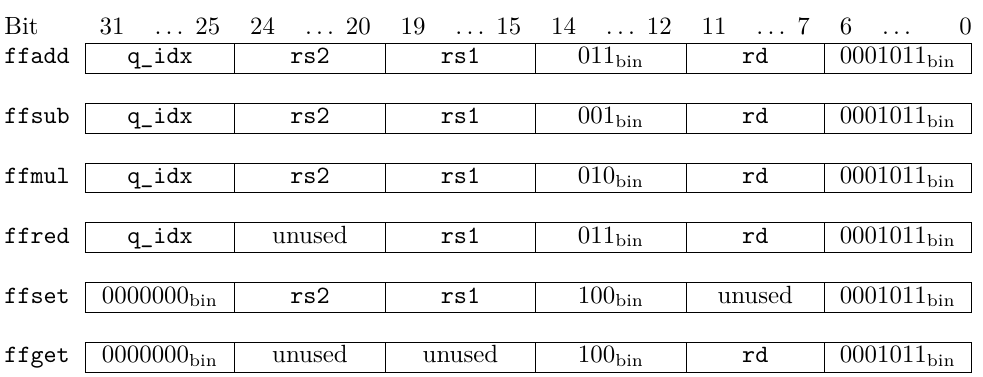
Figure 5: The instruction format for the custom finite field arithmetic